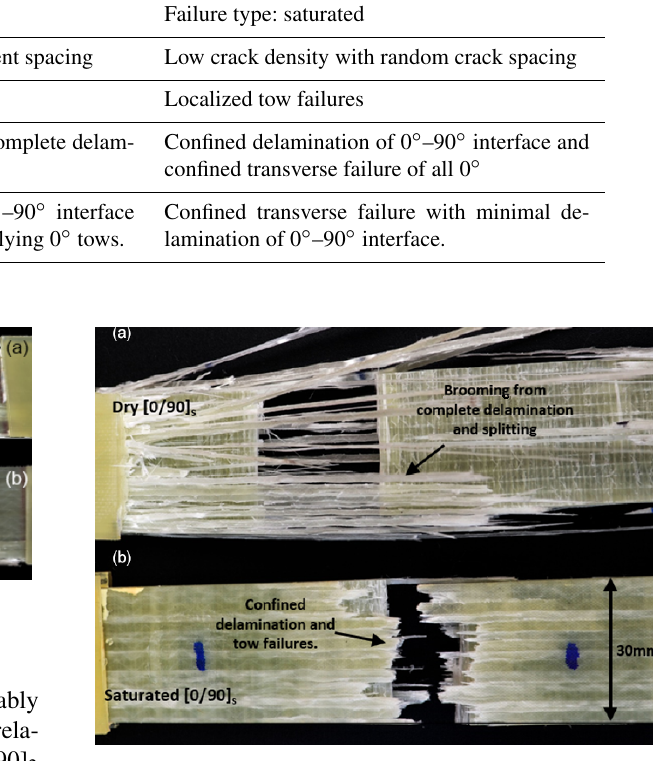
Figure 8. Failed [0/90] s coupons dry (a) saturated (b) .